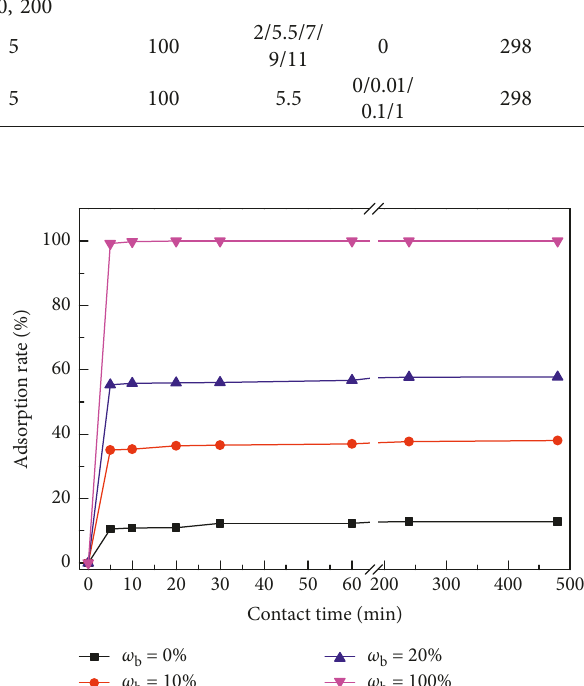
Figure 1: Influence of contact time on Pb(II) adsorption ( s / w � 5g · L − 1 ; pH � 5.5; C i � 100mg · L − 1 ; T � 298K; ω b is the mass content of bentonite in the soil